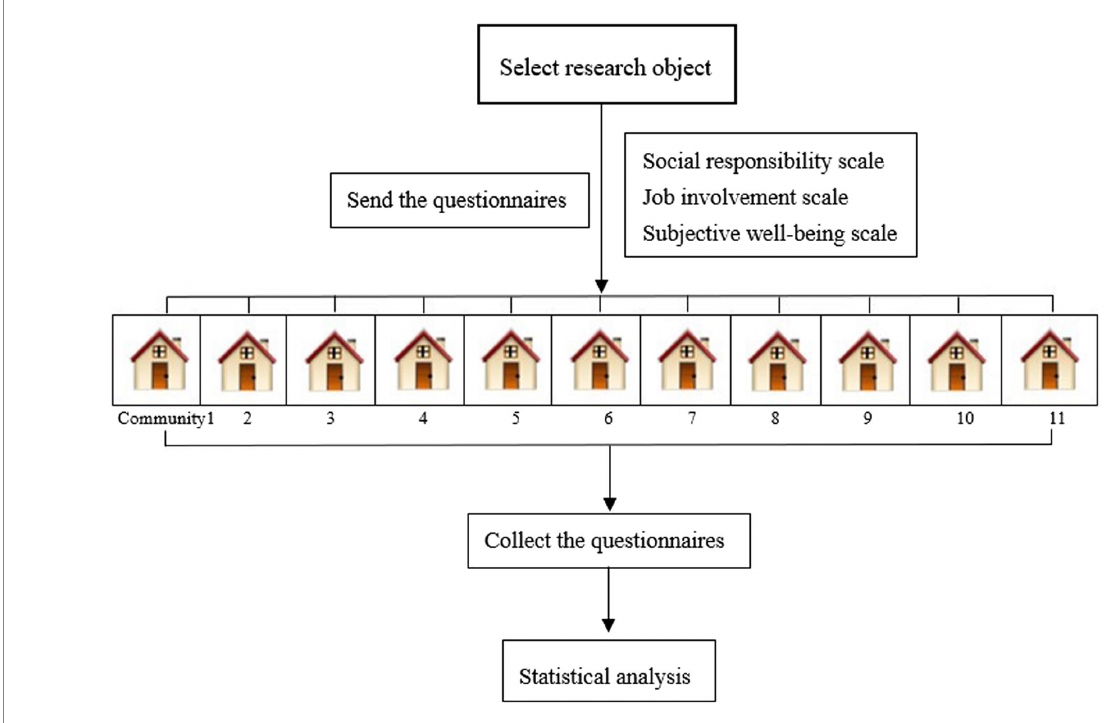
FIGURE 1 The experimental process.